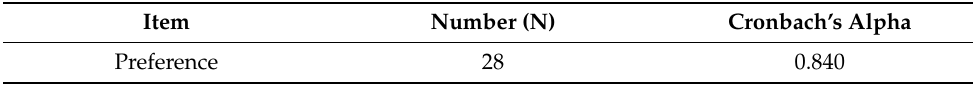
Table 4. Internal consistency of the used